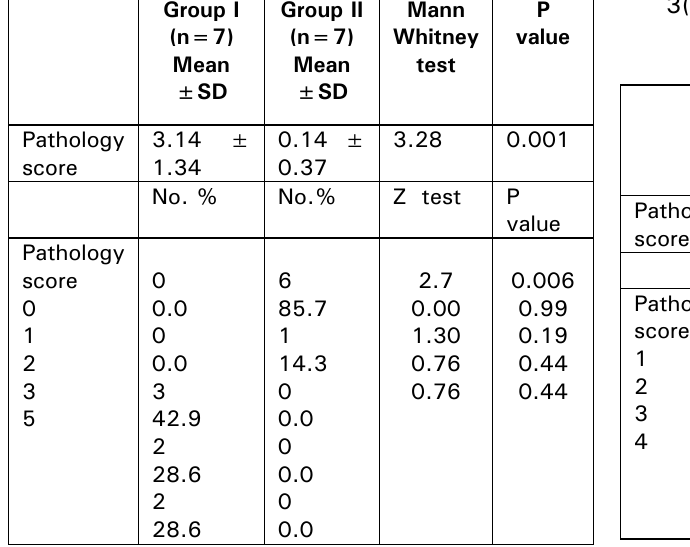
Table4: comparison between day5 pathology scores between cisplatin-induced AKI rats that were treated with lithium chloride in day 3(GroupIII) and rats that were treated with